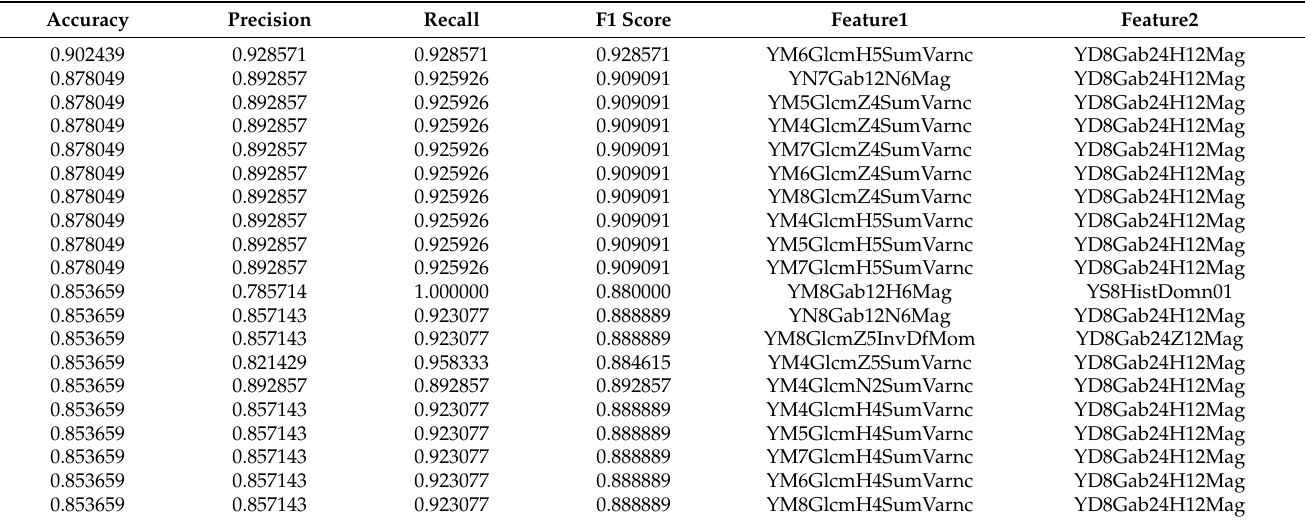
Table 4. The best 20 pairs of features when the inner prostate region is used to calculate